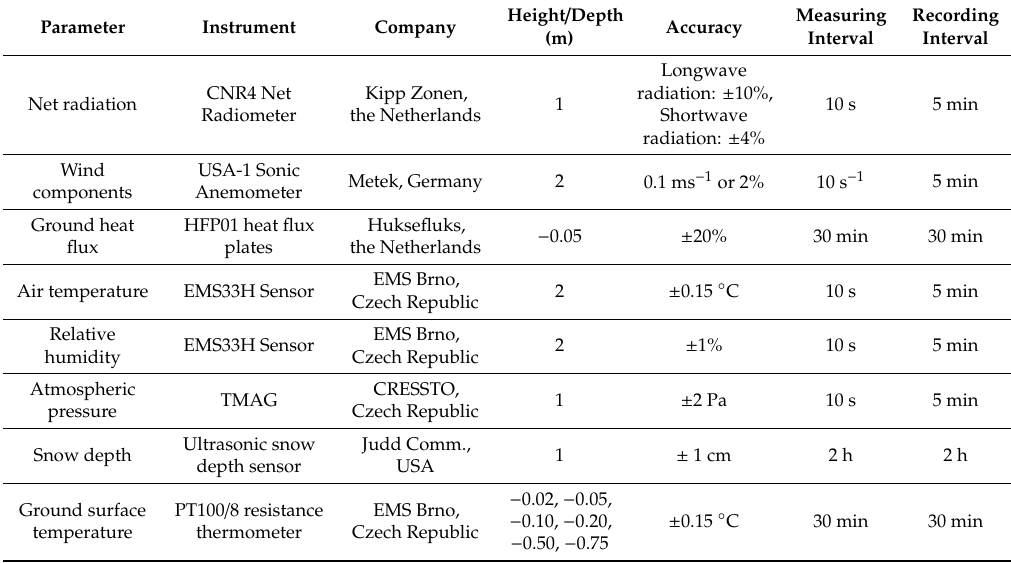
Table 1. Overview of meteorological parameters (“Parameter“) measured on James Ross Island during 23 January–20 March, 2018. In the “Height / Depth“ column, positive numbers refer to height above the ground, while negative numbers refer to